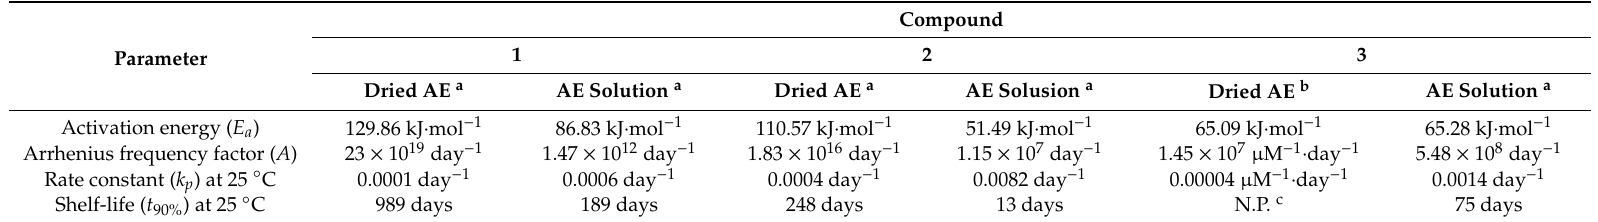
Table 3. Predicted shelf-life ( t 90% ) of compounds 1 – 3 in dried AE powder and AE solution at 25 ◦ C using an Arrhenius